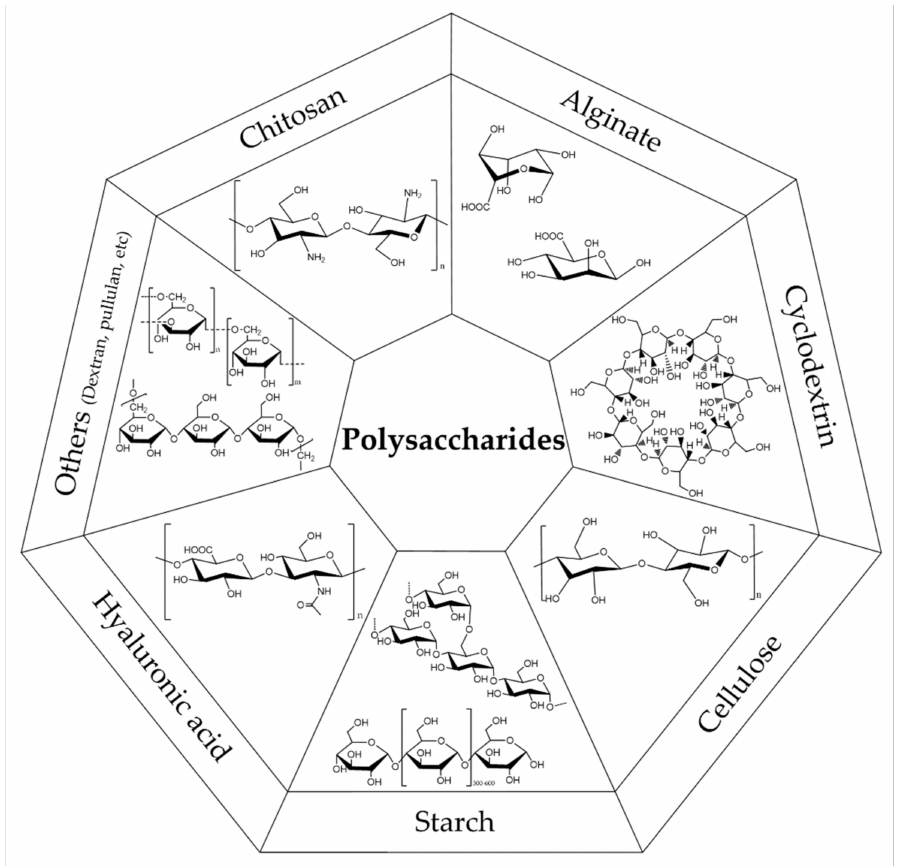
Figure 2. Chemical structures of polysaccharides commonly used in textile